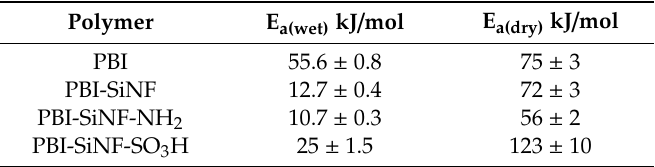
Table 4. Activation energies for the PBI composite membranes in wet and dry conditions for the temperature interval 20–90 ◦ C.